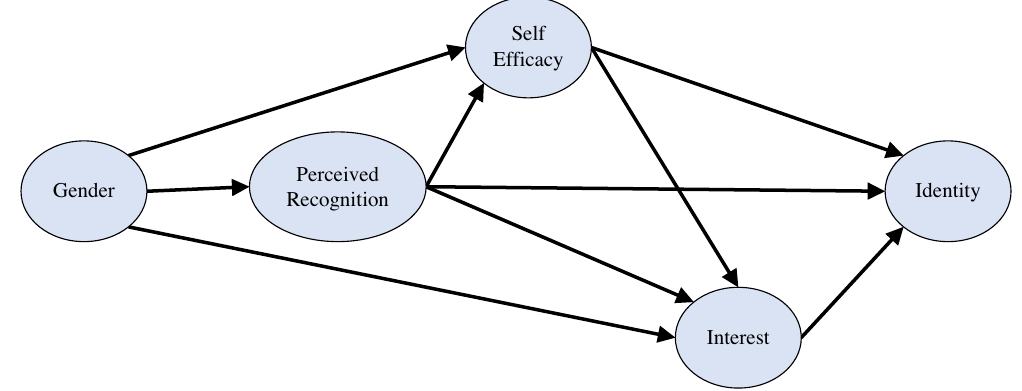
FIG. 1. Schematic representation of the model based on the theoretical framework. From left to right, all possible paths were considered. Some, but not all, of the regression paths are